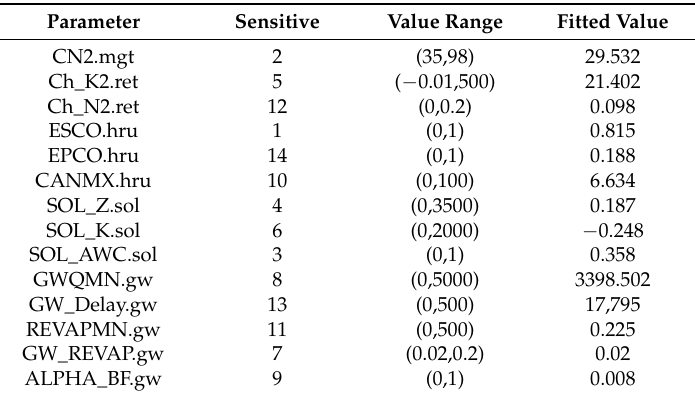
Table 5. Parameter sensitivity